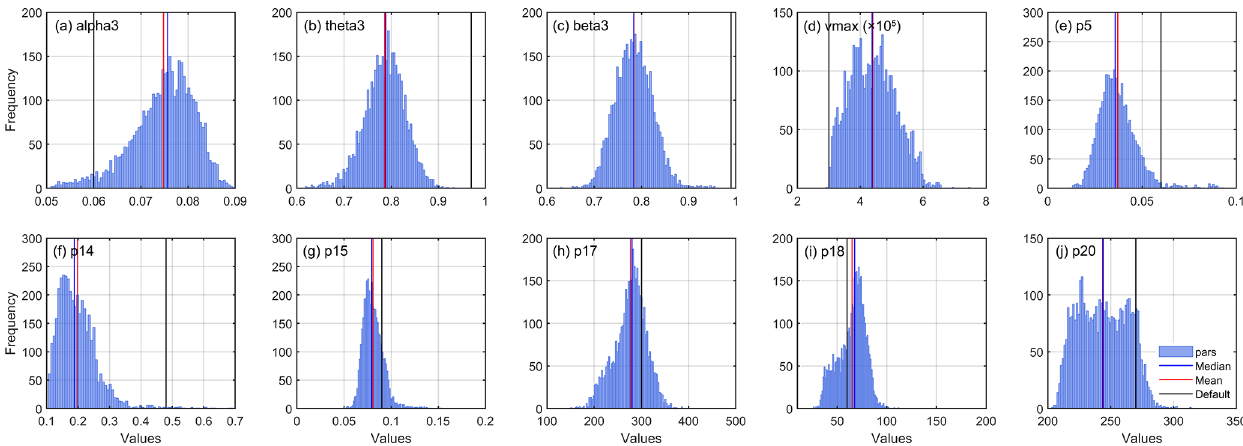
Figure 3. Histogram distribution of optimal parameters from all samples using the MASM optimization.